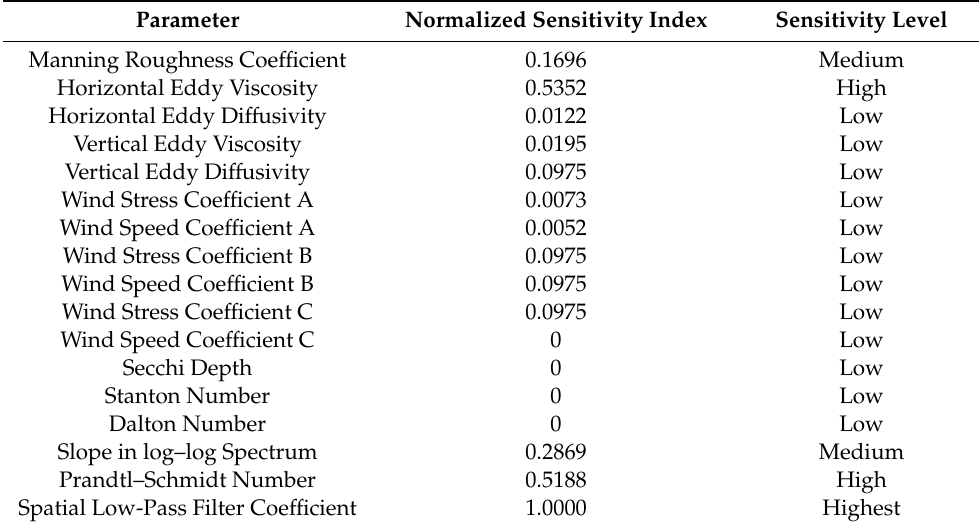
Table 1. Sensitivity analysis results using the Levenberg–Marquardt algorithm (PEST) tool [41,46]